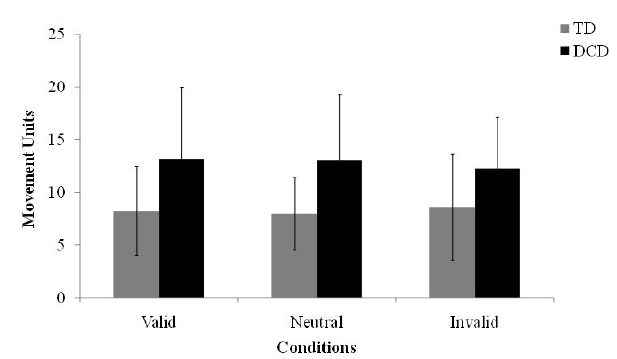
Figure 5. Movement units of children with developmental coordina- tion disorder (DCD) and typically developed (TD) children under the valid, neutral, and invalid pre-cue information